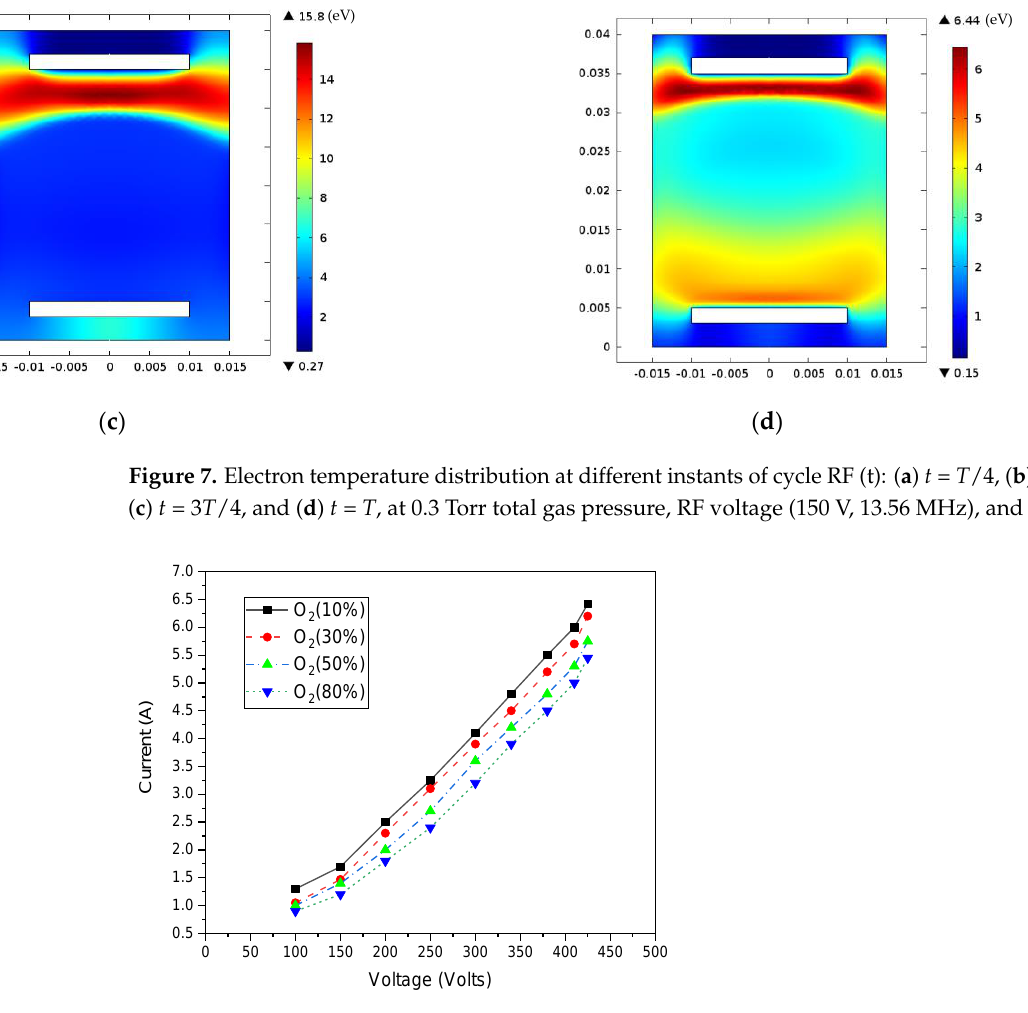
Figure 9. The discharge voltage and input power as a function of current at 30% O 2 gas rate, f= 13.56 MHz, and working pressure 0.3 Torr. The impact of the applied voltage on electron density and temperature has been also studied (see Figure 10). Herein, the use of elevated voltage increases electron energy, which enhances ionization and excitation and generates significant electron density. The behavior of the electron temperature under voltage variation is found to be similar to that observed for electron density.